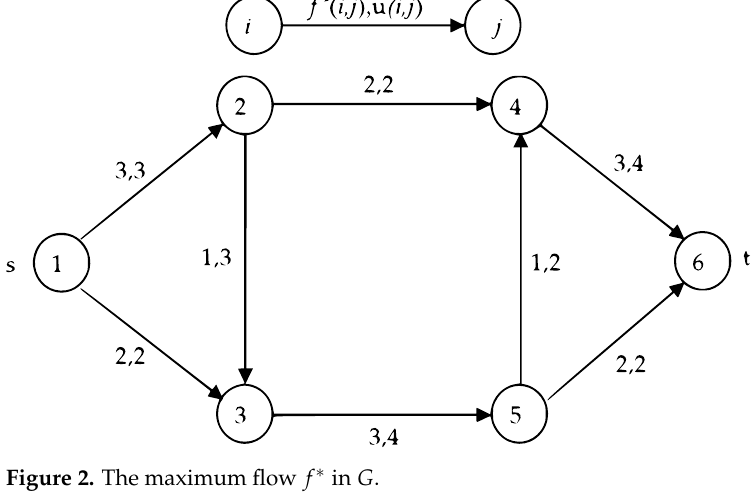
Figure 2. The maximum flow f ∗ in G .